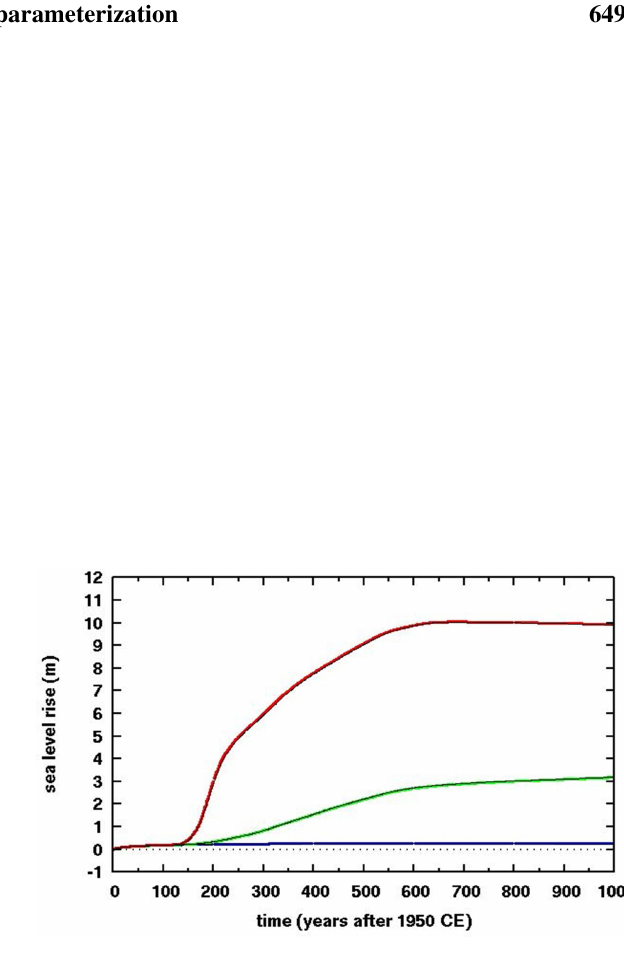
Figure C1. Equivalent global sea level rise in simulations of future West Antarctic ice retreat with climate forcing based on the RCP8.5 greenhouse-gas scenario. Thick colored lines: as in the main pa- per except with the previous parameterization of crevasse depths based on divergence. Thin black lines: as in the main paper (which includes the new crevasse depth parameterization). Blue: control (perpetual modern climate). Green: with RCP8.5 forcing, without hydrofracturing or cliff failure. Red: with RCP8.5 forcing, with hy- drofracturing and cliff